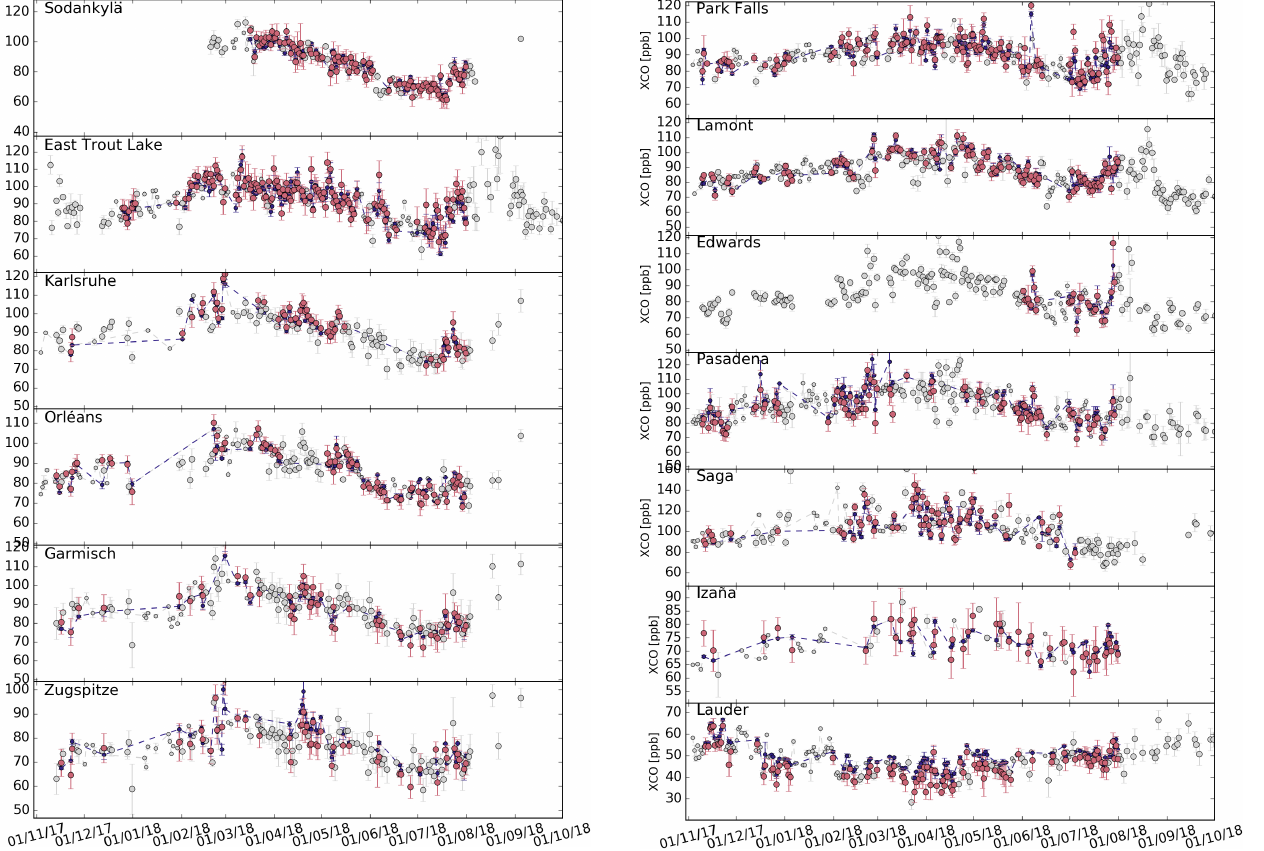
Figure 2. The same as Fig. 1 but for different TCCON